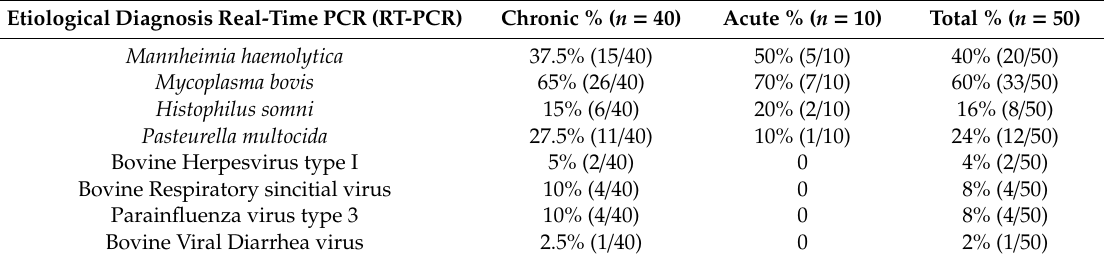
Table 6. Summary of the di ff erent etiologies found in each type of lesion by polymerase chain reaction (PCR) n :